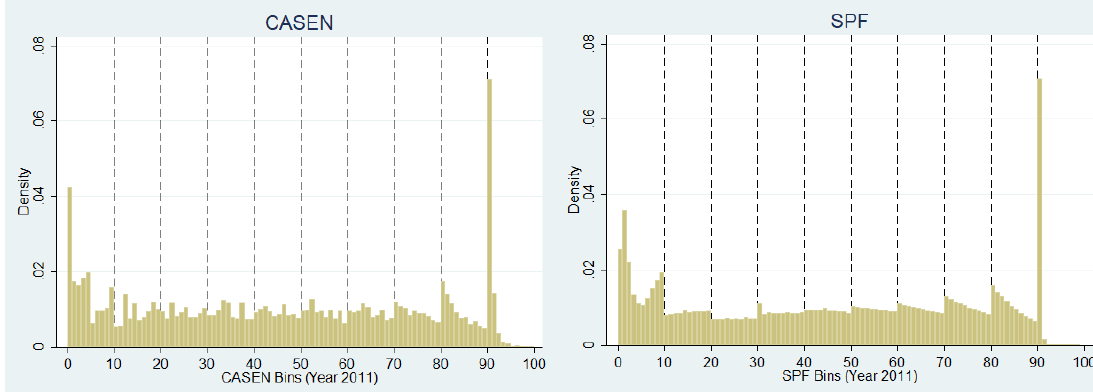
Figure 5: One Hundred Bins of Income per Capita in CASEN and the SPF